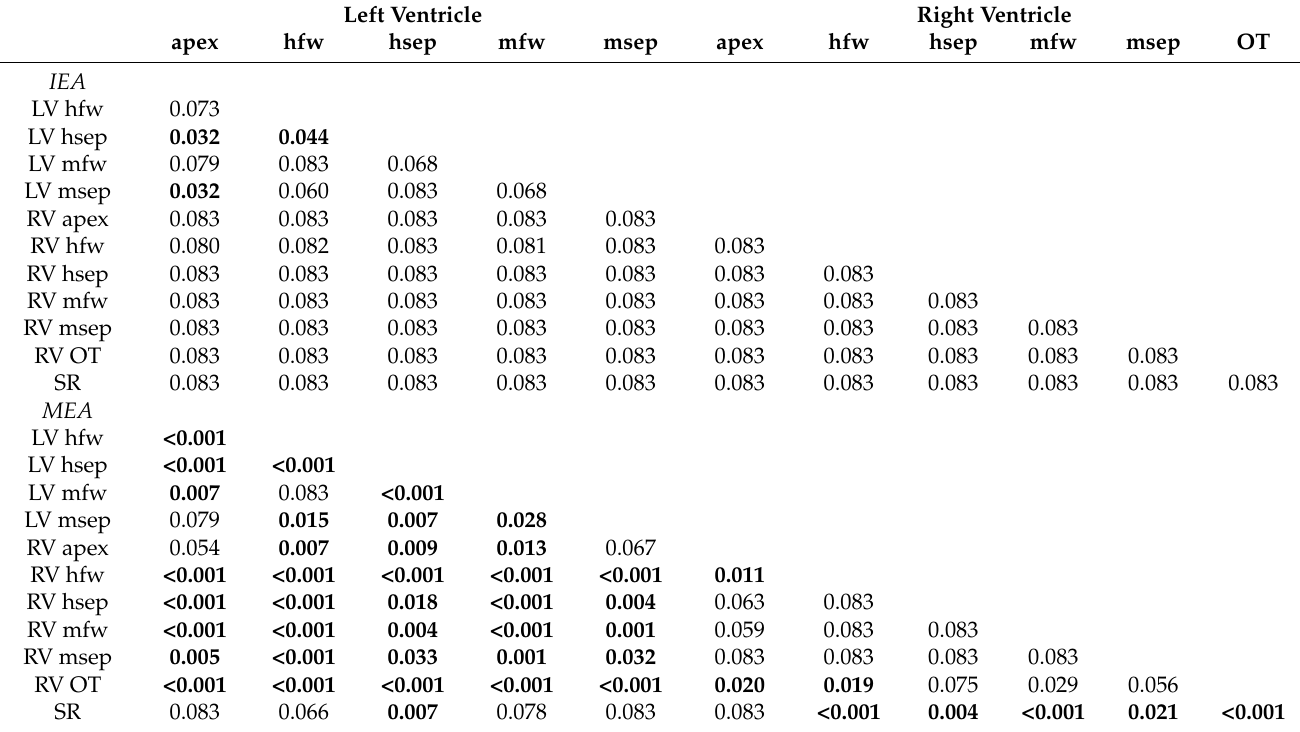
Table 2. Contingency table with the significant results for the post hoc analysis of the ANOVA for each combination of induced ventricular premature depolarizations and each combination of induced ventricular premature depolarizations and sinus rhythm. The ANOVA was conducted based upon the initial electrical axis and maximum electrical axis calculated from each QRS complex. A p < 0.05 is considered a significant difference and is shown in bold. Left Ventricle Right Ventricle msep apex hfw hsep mfw msep